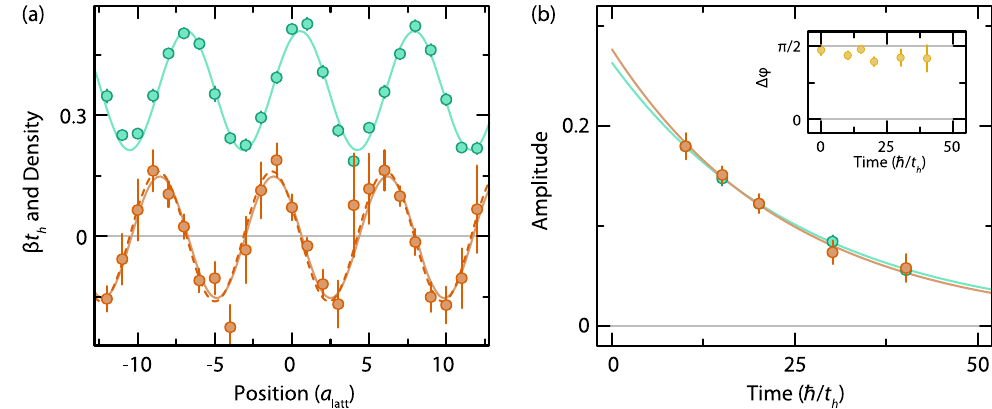
FIG. 5. Local inverse temperature. Near infinite temperature, the density of singles can be used for thermometry. For a tilt strength of Fa =t 3 . 4 ð 1 Þ [the potential is V ð x Þ ¼ − Fx ] and periodic modulation of wavelength 7.69(3) a h ¼ latt component density (green) and the density of singles (not shown) in order to extract the local inverse temperature of the cloud (orange). (a) The measured average single-component density (green circles) and extracted inverse temperature β t h (orange circles) with sinusoid fits (solid lines) after a decay time of 15.1 ℏ =t h . In the case of the inverse temperature, the dashed line is the predicted inverse temperature profile from the density fit and local equilibrium [Eq. (1)]. The fitted offset of the inverse temperature is agreement with an infinite average local temperature. (b) The amplitude of the density (green) and inverse temperature (orange) modulations vs time (circles) with exponential decay fits (solid lines). (Inset) The phase difference of the sinusoid fits between the single-component density and the extracted local inverse temperature vs time (yellow